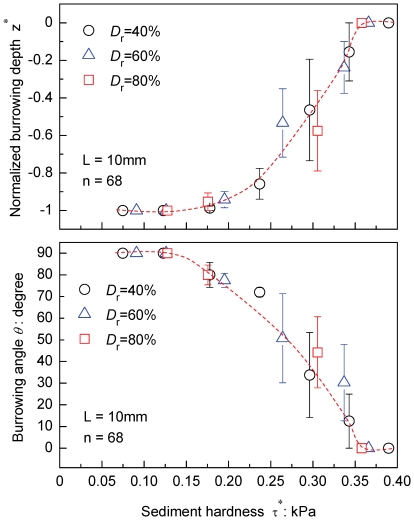
Burrowing criteria and burrowing mode adjustment in Donax semigranosus.Measured normalized burrowing depth z* and burrowing angle θ versus sediment hardness for L = 10 mm. The sediment hardnesses τ* were varied by changing suctions s and sediment relative densities D
r at 40%, 60%, 80%, as shown in Table 2 and Figure 1D. Data represent mean values ± SE. The results of the related statistical analyses (GLM) are shown in Table 3A,B.